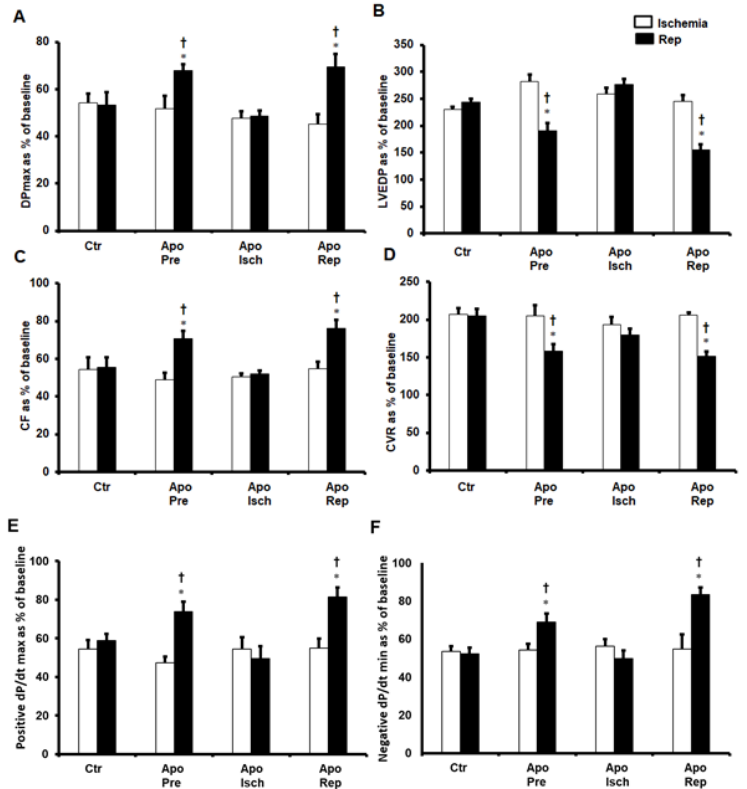
Figure 1. Post-ischemic recovery in cardiac hemodynamics. Cardiac hemodynamics when apocynin was infused before ischemia, during ischemia, or at the beginning of reperfusion, presented as percentage of baseline (n = 8 per group). Data were obtained at the end of reperfusion and presented as means ± SEM. DPmax ( A ), maximum developed pressure; LVEDP ( B ), left ventricular end-diastolic pressure; CF ( C ), coronary flow; CVR ( D ), coronary vascular resistance; positive and negative dP/dt ( E , F respectively), contractility index; Ctr, control; Apo, apocynin; Pre, before ischemia; Isch, during ischemia; Rep, at reperfusion. * p < 0.05 compared to controls. † p < 0.05 compared to ischemia. Infarct size was measured to further validate the role of apocynin in the protection of the heart from I/R and its effects on the cardiac hemodynamics. Infusion of apocynin be- fore ischemia and at the beginning of reperfusion significantly ( p < 0.05) decreased the infarct size as a percentage of LV area, compared to the untreated controls. These results were not reproduced when apocynin was infused during ischemia (Figure 2).